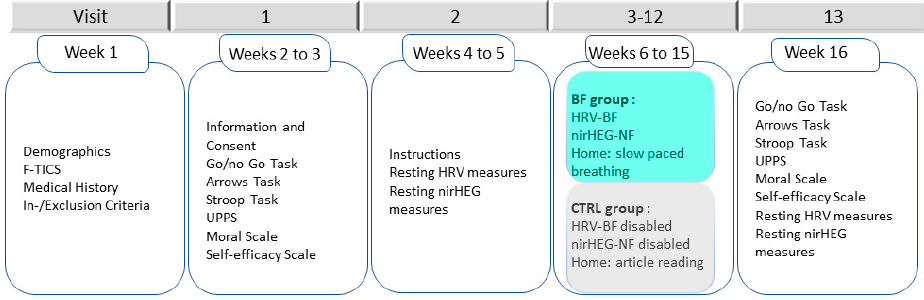
Figure 1. Experimental procedure: schedule of assessments for participants of both groups.